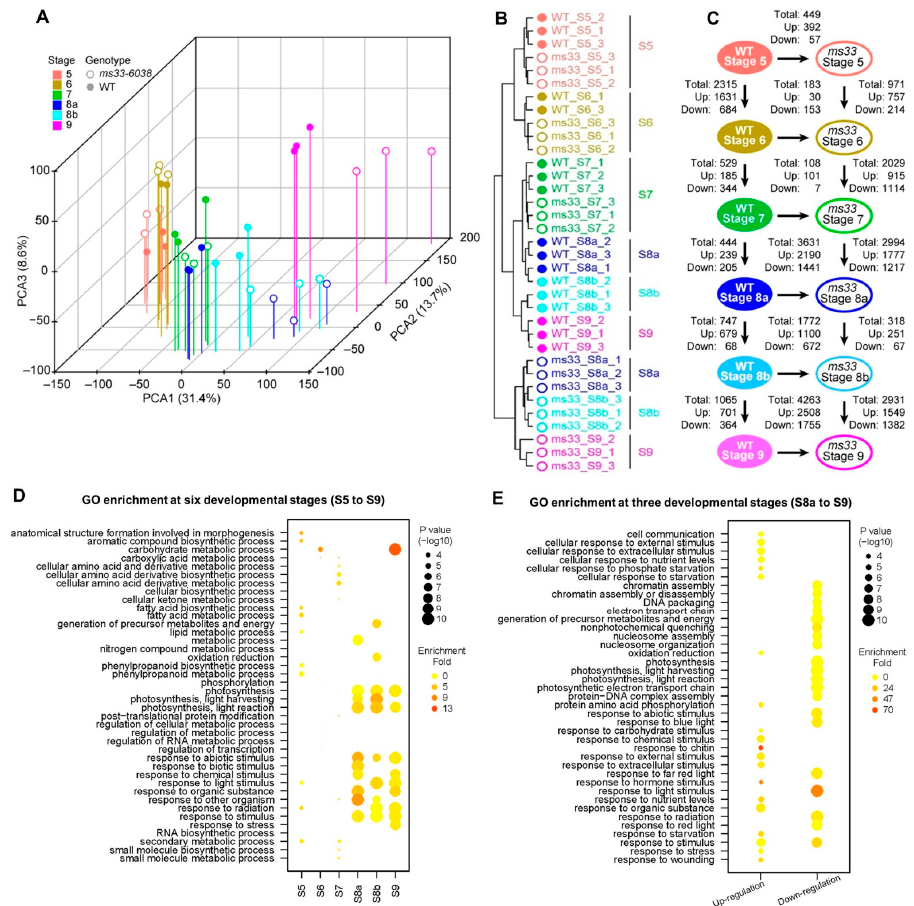
Figure 3. Transcriptome analysis of RNA-seq data of WT and ms33-6038 anthers. ( A ) Principal component analysis of WT and ms33-6038 anther transcriptomes from stages S5 to S9. ( B ) Hierarchical clustering of WT and ms33-6038 anther transcriptomes from stages S5 to S9. ( C ) The number of DEGs between WT and ms33-6038 anther transcriptomes and between adjacent developmental stages from stages S5 to S9. ( D ) GO enrichment analysis of DEGs between WT and ms33-6038 anther transcriptomes at each of six stages. ( E ) GO enrichment analysis of up- or down-regulated DEGs in ms33-6038 anther transcriptome compared to WT from stages S8a to S9. 3.2. ZmMs33 Deficiency Caused Severe Oxidative Stress in Maize Anthers To reveal which type of stress is mainly induced in ms33-6038 anthers, we con- ducted KEGG pathway enrichment analysis and found that genes involved in plant MAPK signaling pathway and plant hormone signal transduction were activated in ms33-6038 anthers, while the downregulated genes mainly functioned in the primary